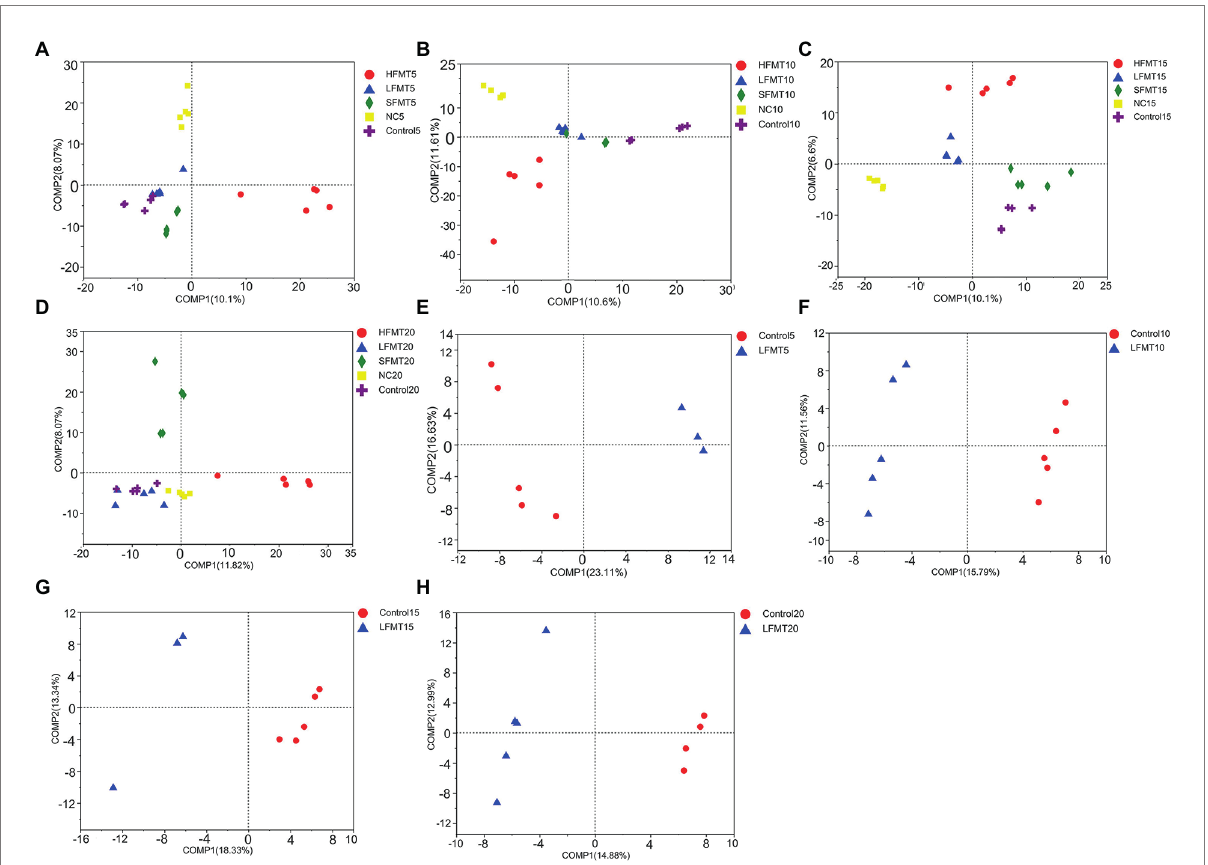
FIGURE 3 PLS-DA score plot to differentiate fecal microbial communities between the FMT and untreated groups at four time points after weaning. (A) Fecal bacterial community among groups at 5 days after weaning. (B) Fecal bacterial community among groups at 10 days after weaning. (C) Fecal bacterial community among groups at 15 days after weaning. (D) Fecal bacterial community among groups at 20 days after weaning. (E) Fecal fungal community among groups at 5 days after weaning. (F) Fecal fungal community among groups at 10 days after weaning. (G) Fecal fungal community among groups at 15 days after weaning. (H) Fecal fungal community among groups 20 days after